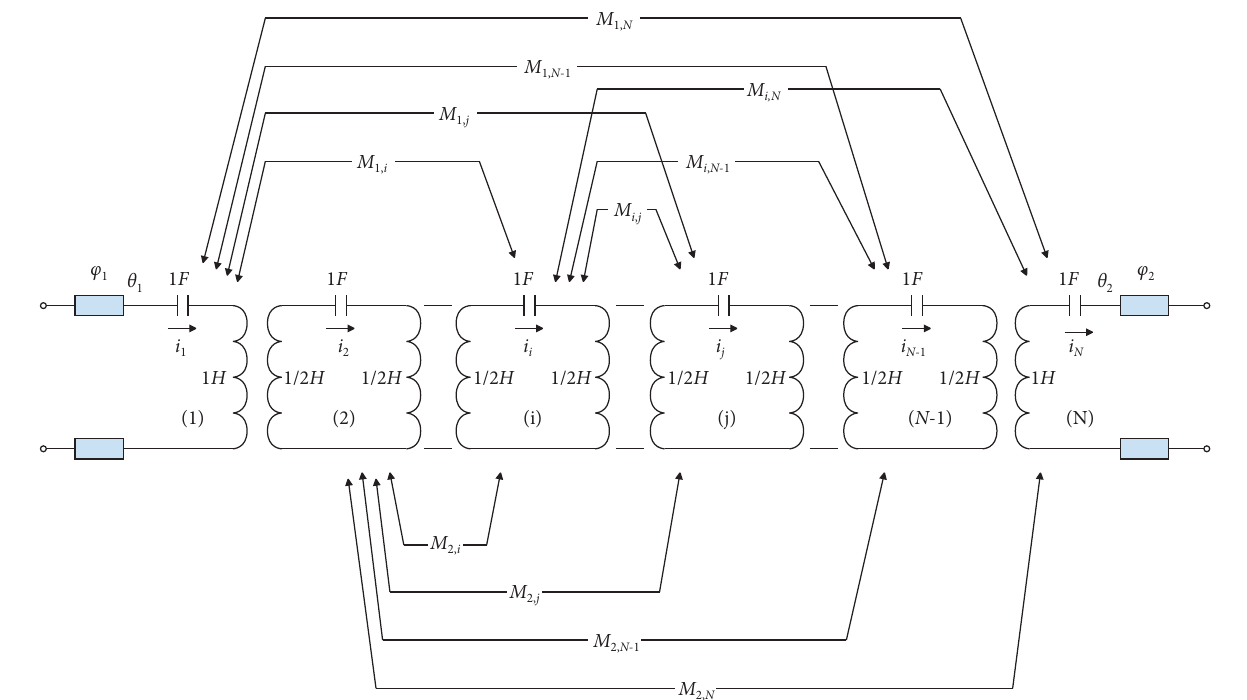
Figure 1: Equivalent circuit model of a cross-coupled filter with loaded